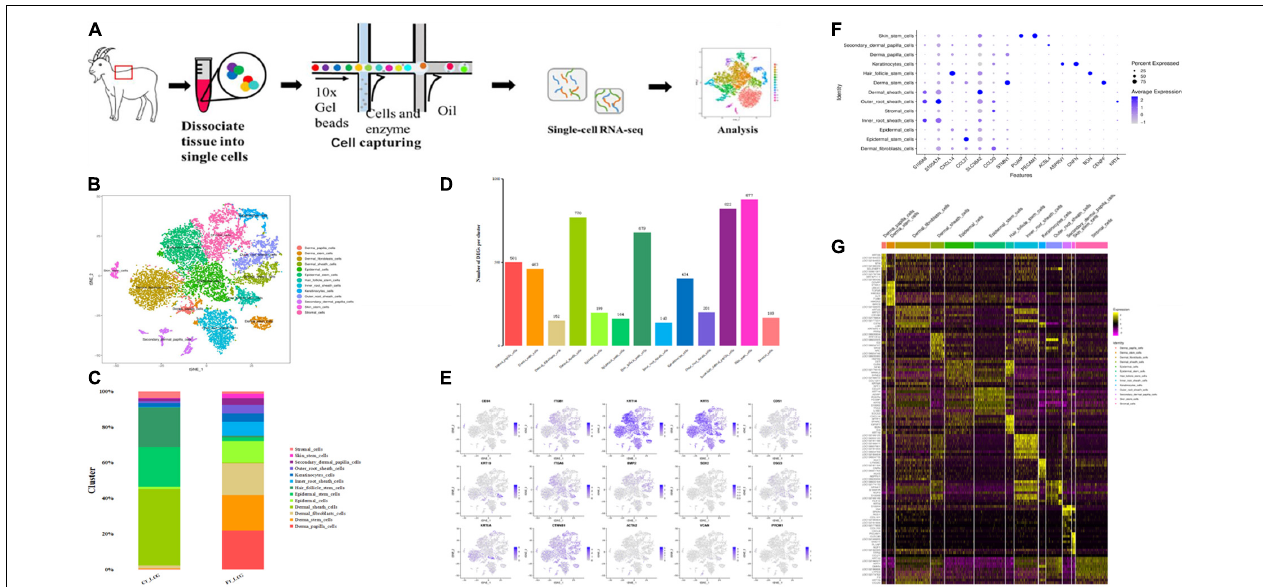
FIGURE 1 | Identification of cashmere goat skin cell types. (A) Schematic representation of cashmere goat skin tissue preparation for single-cell transcriptome analysis. (B) t-SNE clustering of cells based on expression levels of genes. Each color represents a class of cells. (C) Graph showing percentage of each cluster in two samples. (D) Number of DEGs in each cluster. (E) t-SNE plots of marker genes expression value in per cluster. (F) Highly expressed genes in every cell type. (G) Heat map of the top 10 specific marker